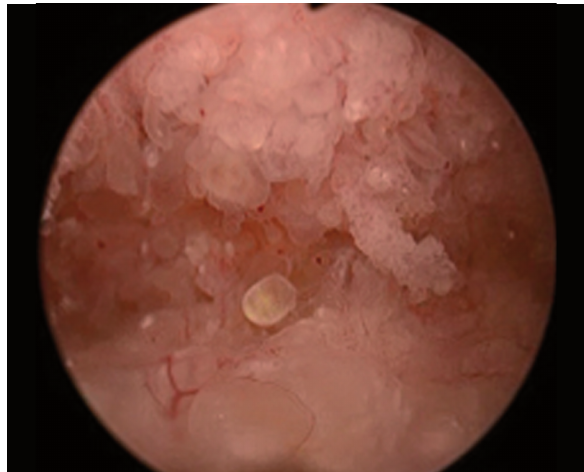
figure 1 - cystoscopic fi ndings of nephrogenic adenoma mimicking other urology pathology.